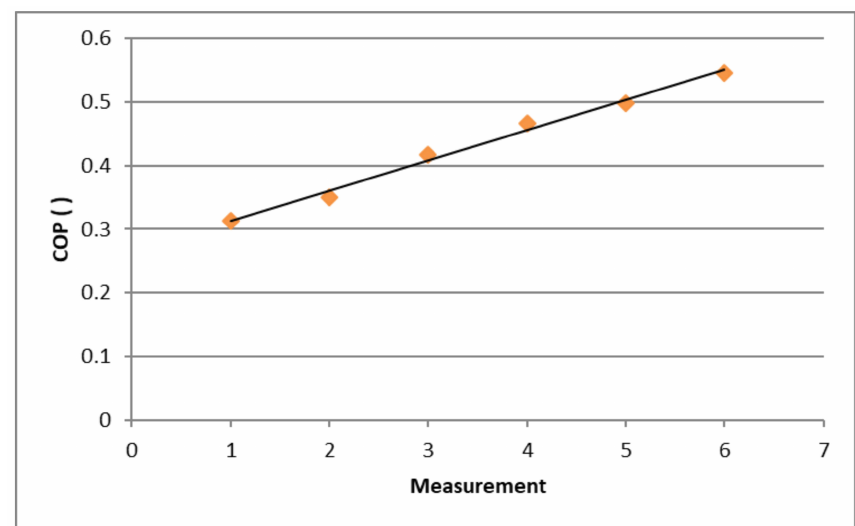
Figure 7. Effect of hot water temperature on COP value.